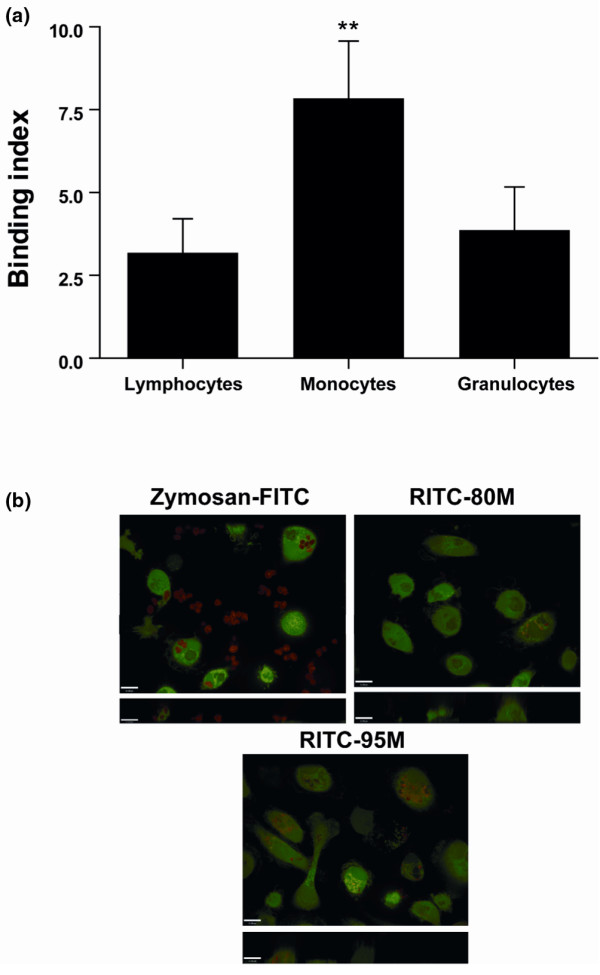
The interaction of chitosan with monocytes, granulocytes, and lymphocytes in whole blood. (a) Whole blood was incubated for 30 minutes with 5 μg/ml rhodamine B isothiocyanate (RITC)-80% deacetylated (80 M) chitosan at 37°C for 30 minutes before analysis by flow cytometry. The binding index was calculated as fluorescence units of each leukocyte population incubated with RITC-80 M chitosan/fluorescence units of leukocyte population in the absence of RITC-chitosan. Results are presented as mean ± standard error. P values from Student's two-tailed unpaired t-test: **P < 0.005 versus autofluorescence for each leukocyte population. (b) Macrophages were seeded on glass slides (2 × 106 cells/ml) in RPMI 1640 supplemented with 0.1% decomplemented fetal bovine serum, pre-stained with 1 μg/ml calcein AM for 30 minutes at 37°C, and incubated with 100 μg/1 × 106 cells RITC-zymosan for 1.5 hours (a positive control), 15 μg/ml RITC-80 M, or RITC-95% deacetylated (95 M) chitosan for 3 hours at 37°C. Macrophages were then visualized live through a spinning disc confocal microscope with a 63× objective. The top panels are images taken in the X-Y plane and the lower panels are images taken in the X-Z plane. This figure represents the results of three independent experiments.